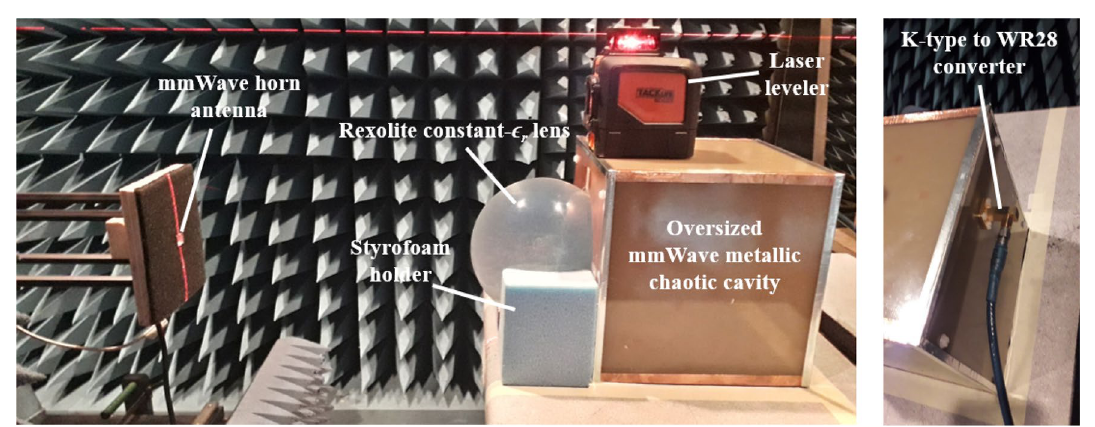
Figure 6. Lens-loaded cavity hardware and measurement setup in a near-field anechoic